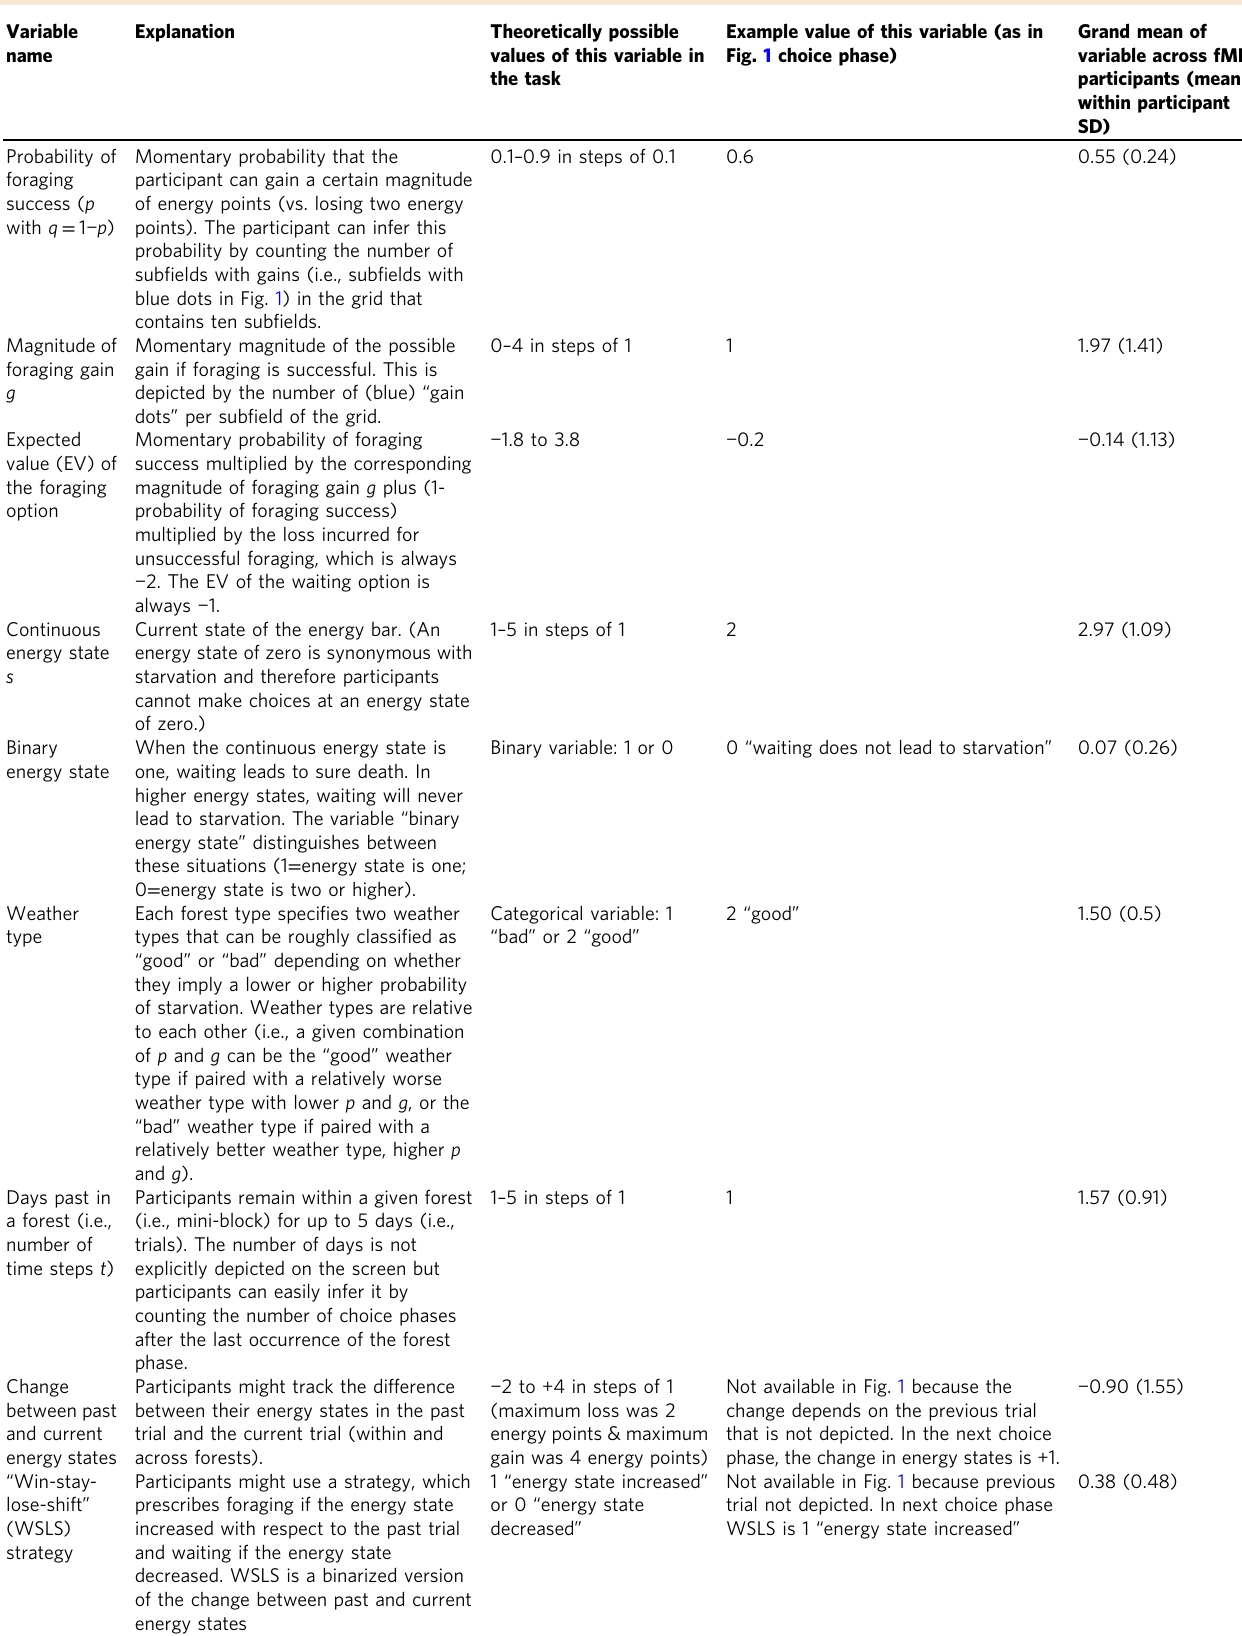
Table 1 Overview of heuristic